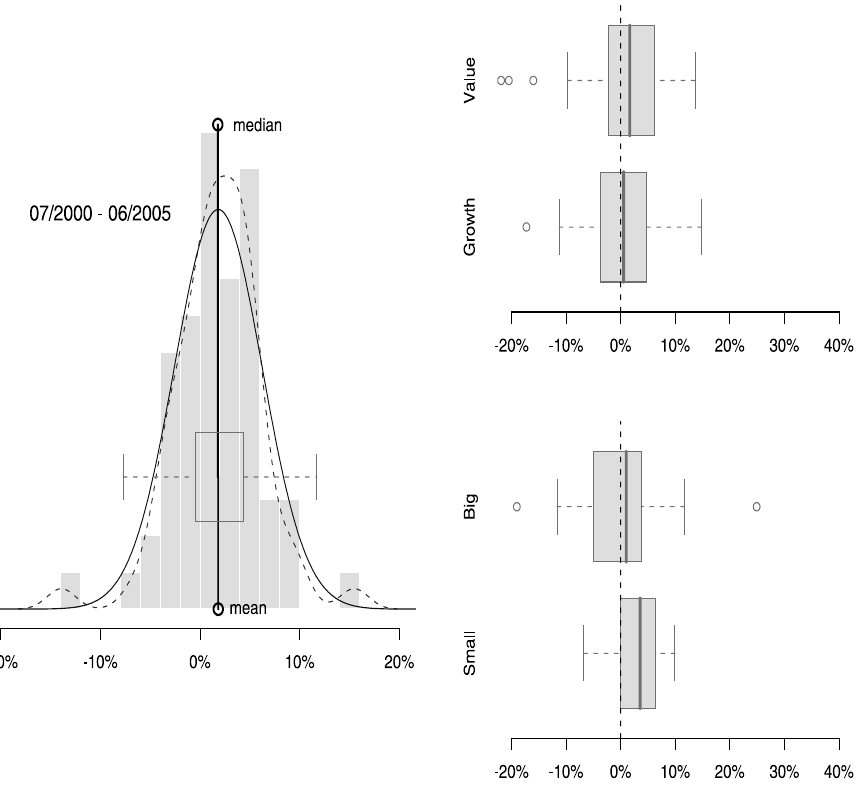
FIGURE 3: Distribution of the Accounting Premium among all firms, within different size class, for value stocks and growth